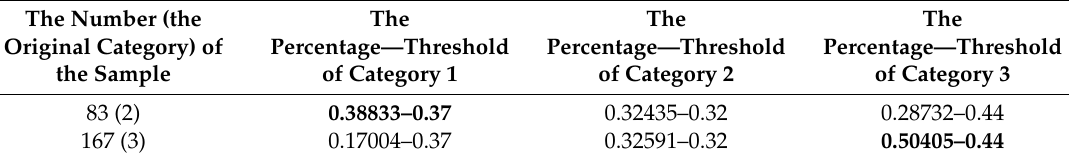
Table 1. The percentages of the two categories of Haoyu21 corn seed samples.